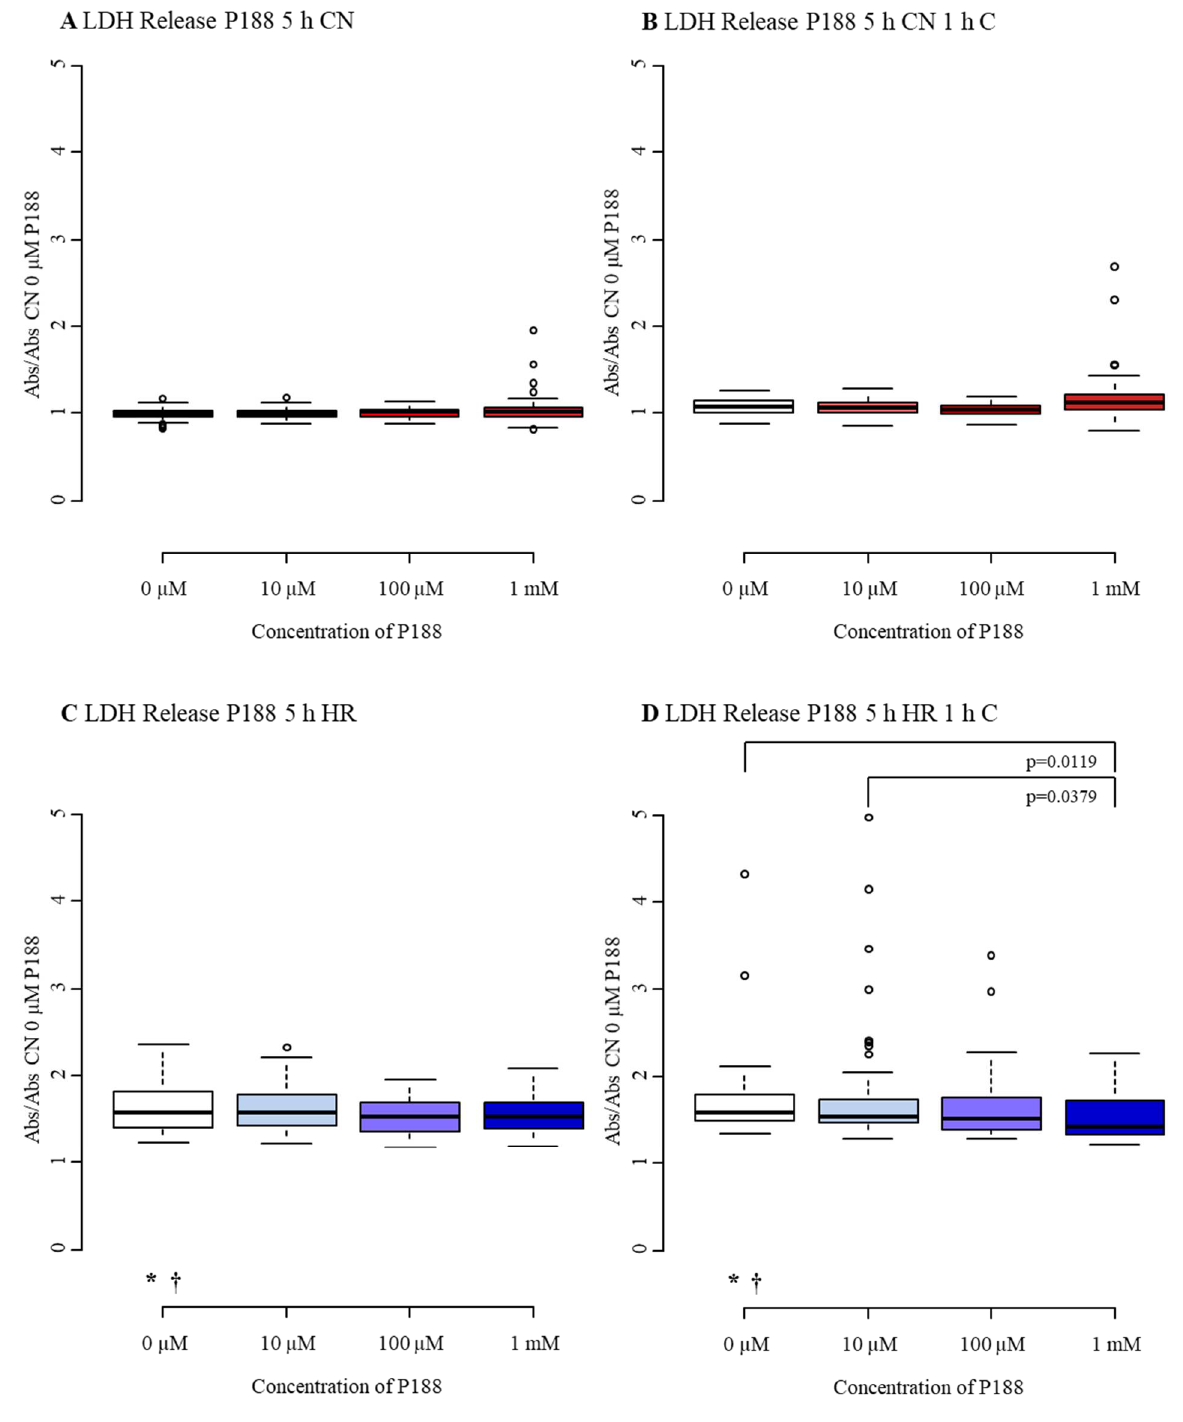
Figure 5. Cytotoxicity/membrane damage after 5 h injury and treatment with 0 µ M, 10 µ M, 100 µ M, and 1 mM of P188. ( A ) normoxia (CN-C); ( B ) normoxia and 1 h compression (CN+C); ( C ) hypoxia (HR-C); ( D ) hypoxia and 1 h compression (HR+C). Data visualized as boxplots (median, 25th, 75th percentile, whiskers: minimum, maximum, dots: potential outliers); p < 0.05; n = 12–18 experiments/group. Significances between different concentrations of P188 are displayed as brackets, significances between A, B, C, and D for 0 µ M P188 are represented by symbols (* vs. CN-C 0 µ M P188, † vs. CN+C 0 µ M P188). Abbreviations: Abs, absorbance; C, compression; CN, control/normoxia; h, hours; HR, hypoxia/reoxygenation; LDH, lactate dehydrogenase; mM, millimolar; µ M, micromolar; P188, Poloxamer 188. Colors: red, normoxia; blue, hypoxia/reoxygenation. The shadows of red/blue represent the different concentrations of